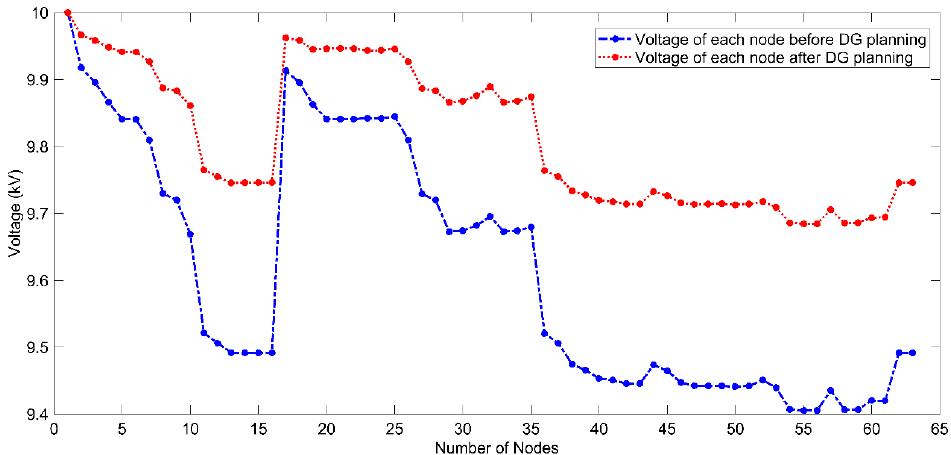
Figure 5. The voltage of each node after the DG access (red line) is significantly higher than before the DG access (blue line).